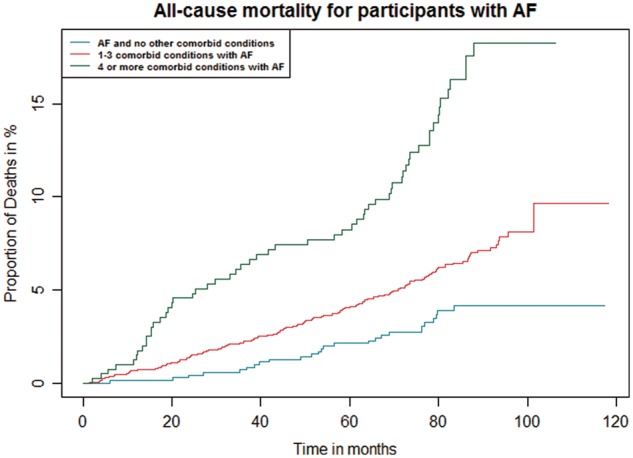
Cumulative survival plot showing probability of all-cause mortality among self-reported AF participants with different levels of multimorbidity. n = 3651; AF participants (107 excluded due to missing values).